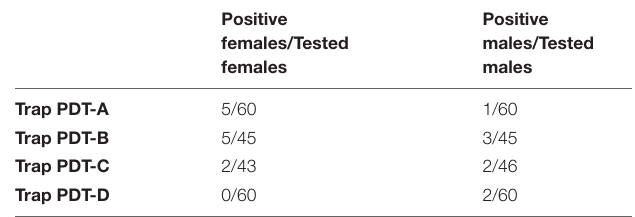
TABLE 10 | Total positive flies out of flies tested at Piedmont Research Station blackberry plot by trap location.